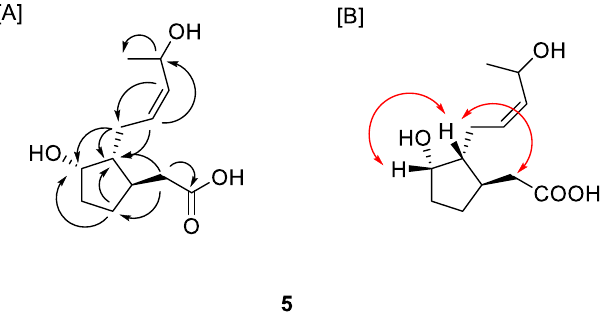
Figure 2. [A] Key HMBC ( → ) and [B] NOESY ( ↔ ) correlations of compound 5.